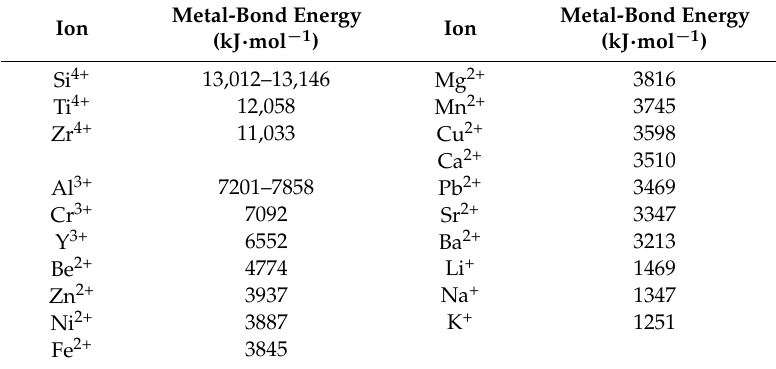
Table 3. Metal-oxygen bond energy for some metal cations